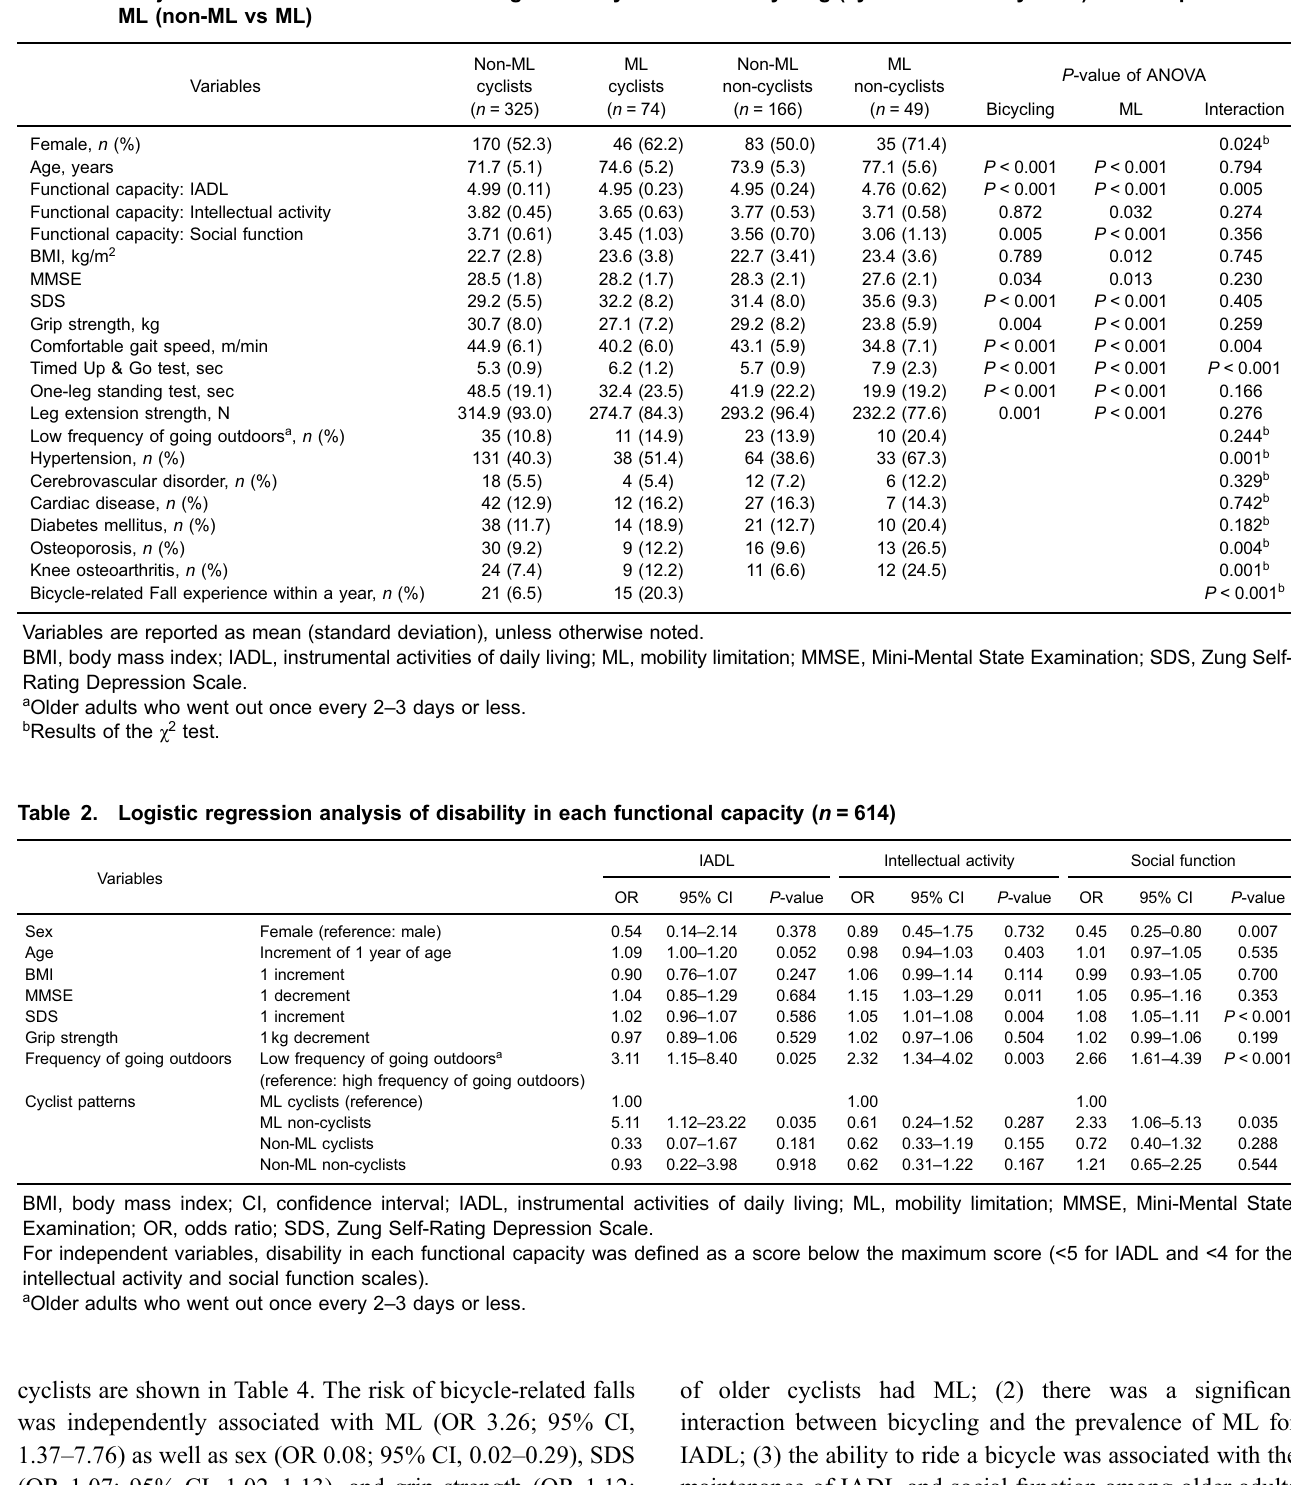
Non-ML ML Non-ML ML cyclists cyclists non-cyclists non-cyclists